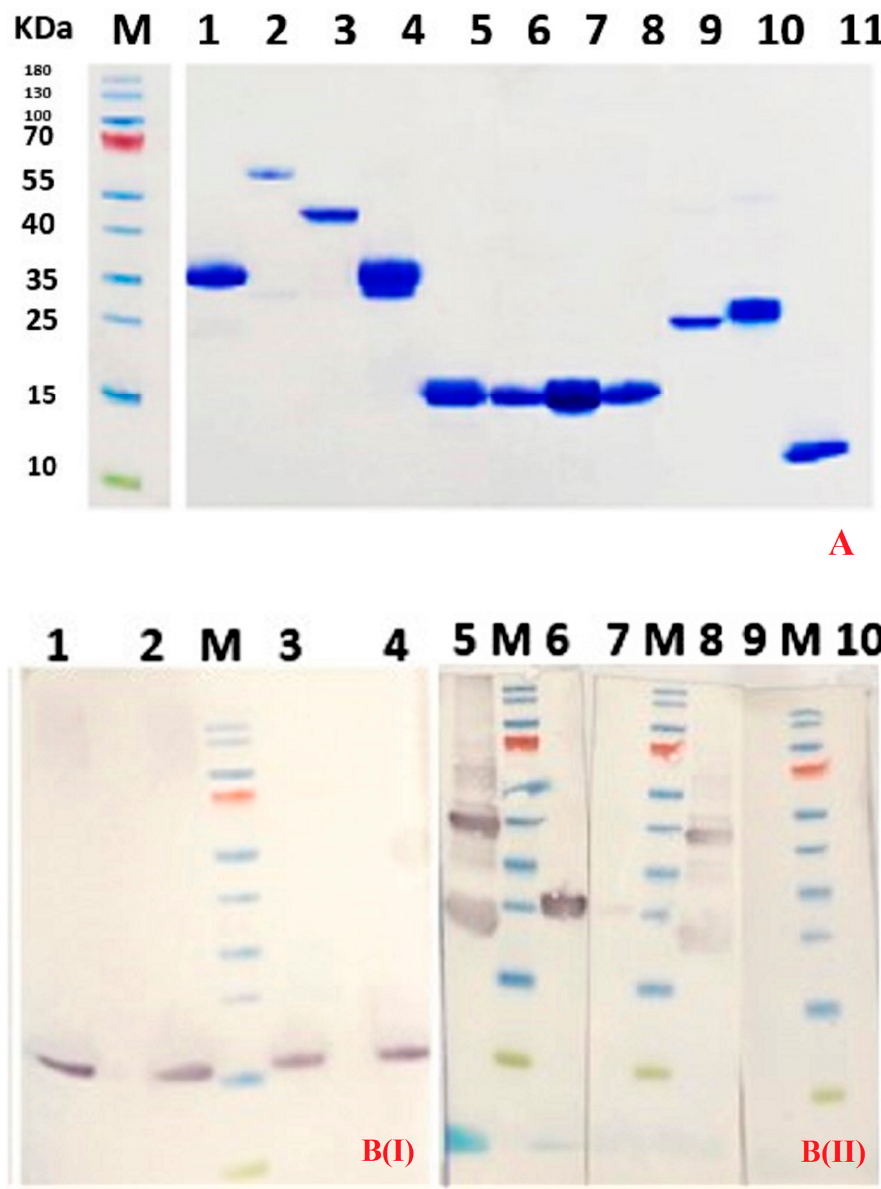
Figure 1. Panel A: SDS-PAGE gel stained with Coomassie blue R250. Lanes from left to right: lane M: protein size marker with the molecular mass indicated in KDa, Lane 1: Nb28-113, lane 2: Nb28 4 ; lane 3: Nb28 3 ; lane 4: Nb28 2 ; lane 5: Nb24; lane 6: Nb22; lane 7: Nb28; lane 8: Nb50, lane 9: TRAIL; lane 10: DR5; lane 11: Stx2a-B 5 . All samples were treated with dithiotreitol before electrophoresis. Panel B ( I ) Western blot analysis of different Nbs used in this study: Lane 1: Nb22; lane 2: Nb24; lane 3: Nb28; lane 4: Nb50. The membrane was treated with anti HA tag monoclonal antibody and goat anti mouse IgG conjugate. Lane M contains protein size markers. Panel B ( II ) Western blot analysis revealing the interaction between DR5 and Nb24 or Nb28. Lanes 5 and 6: DR5 without or with dithiotreitol and probed with Nb24; Lanes 7,8: DR5 with or without dithiotreitol and probed with Nb28. Lanes 9 and 10: DR5 without or with dithiotreitol (membranes were not incubated with Nb). All membranes were incubated with anti HA tag monoclonal antibody and goat anti mouse IgG conjugate. Lanes M contain protein size